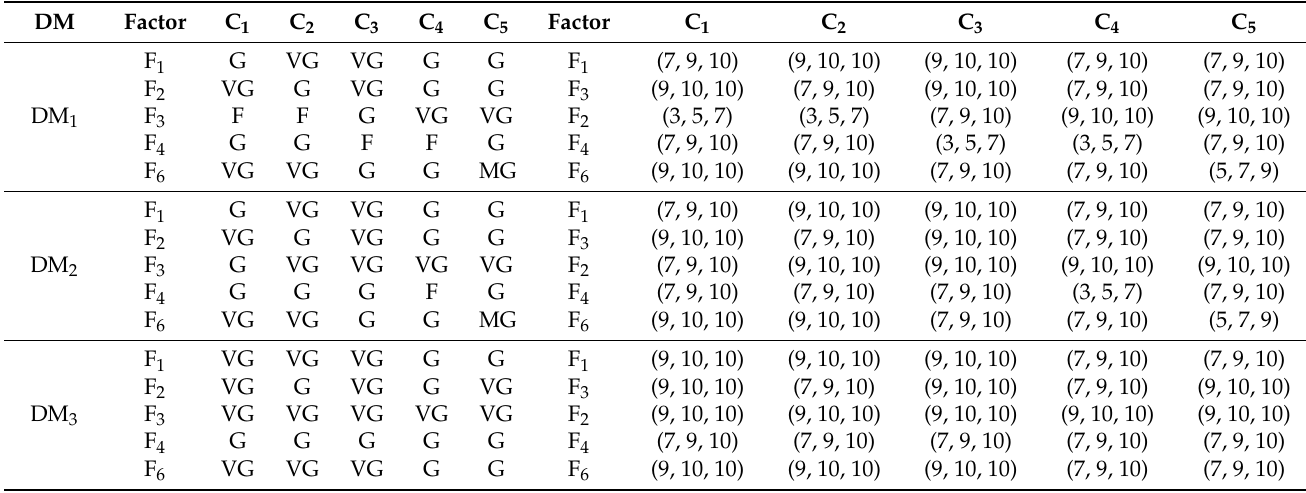
Table 17. The linguistic ratings of the six factors by DM under all criteria.